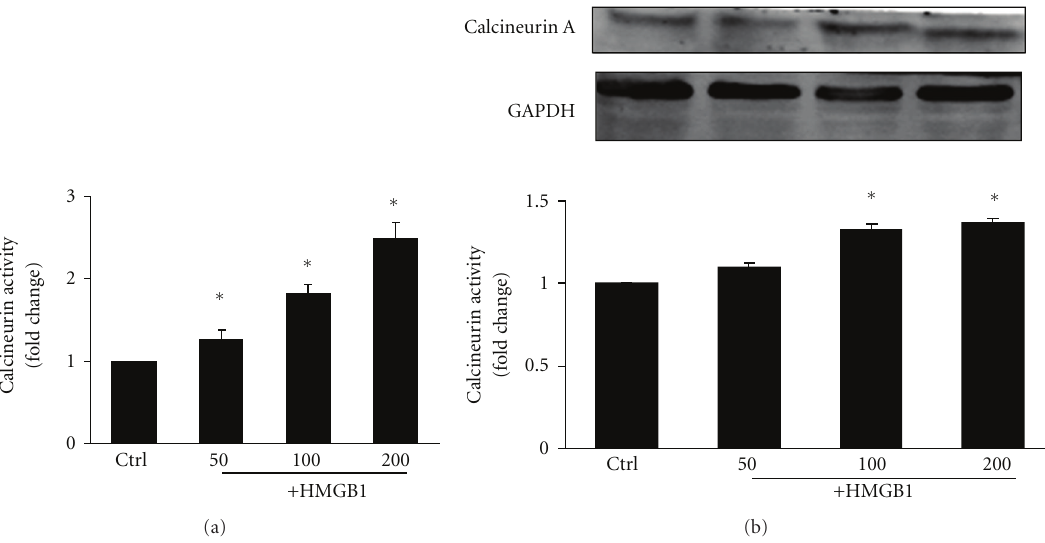
Figure 2: E ff ect of di ff erent concentrations of HMGB1 (50 to 200 ng/mL) on calcineurin activity and calcineurin A protein expression in NRVMs after 24 hours. (a) Calcineurin activity in NRVMs was determined by a calcineurin assay kit. (b) Expression of calcineurin A protein was determined by Western blot analysis, and the integrated optical density (IOD) of ANP expression bands was analyzed. The bar graph represents three independent experiments. ∗ P < 0 . 05 versus control. Ctrl: control